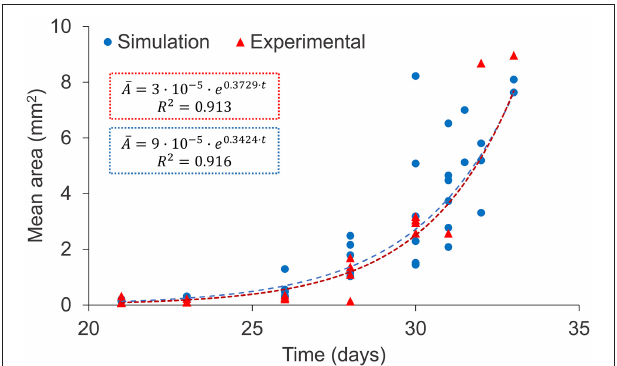
FIGURE 4 | Evolution of the mean area of lesions: experimental data (red triangles) and simulation results (blue circles), both corresponding to series A (Table 1). Exponential fittings to simulation results and experimental data are shown (dotted lines). Two outlying experimental data-points were not taken into account for the fitting.